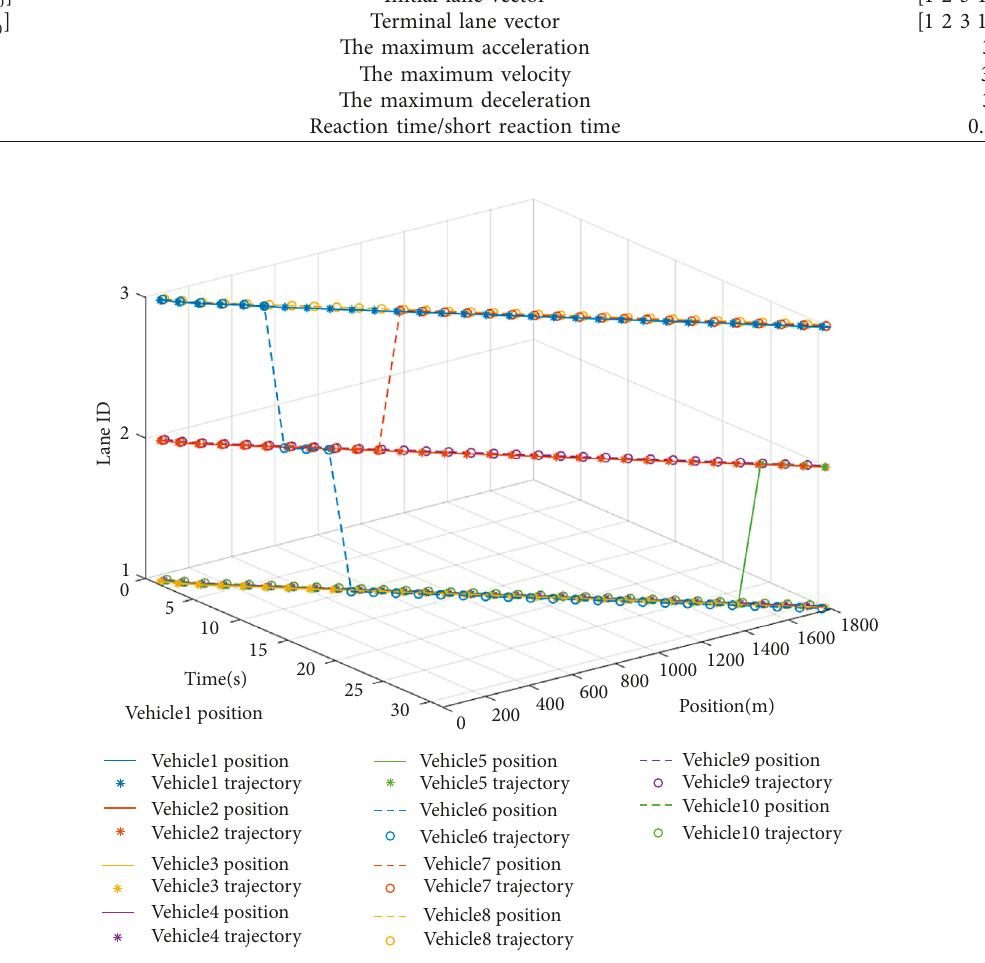
Figure 4: Optimal vehicles trajectories.